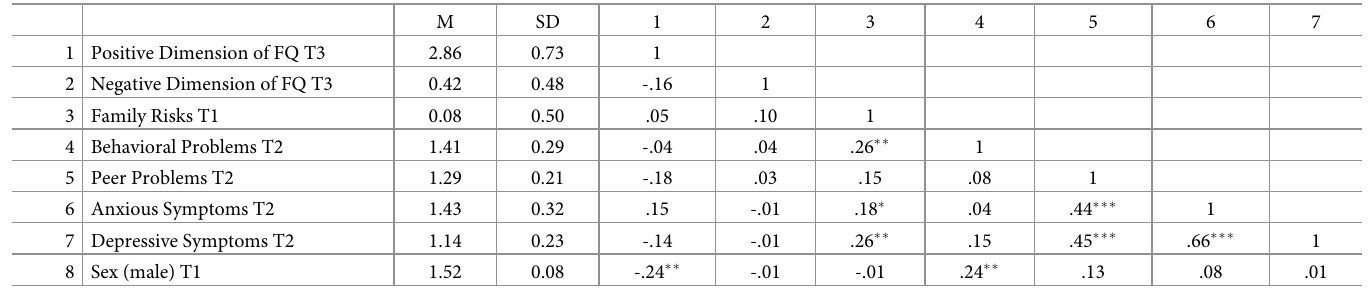
Table 1. Bivariate correlations among all study variables (n =